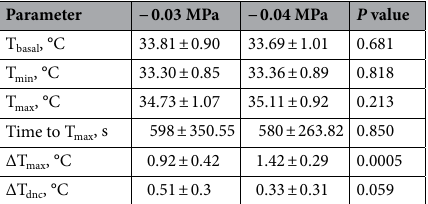
Table 3. Comparison of the parameter values extracted from skin temperature time-courses (mean ± SD) between the two groups.